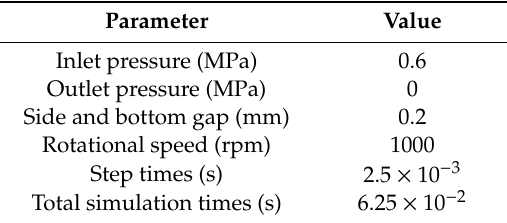
Figure 2. Schematic diagram of ( a ) cathode tool electrolyte outlet slit layout ( b ) flow field simulation geometric model of tool A. Table 1. Flow field simulation parameters.